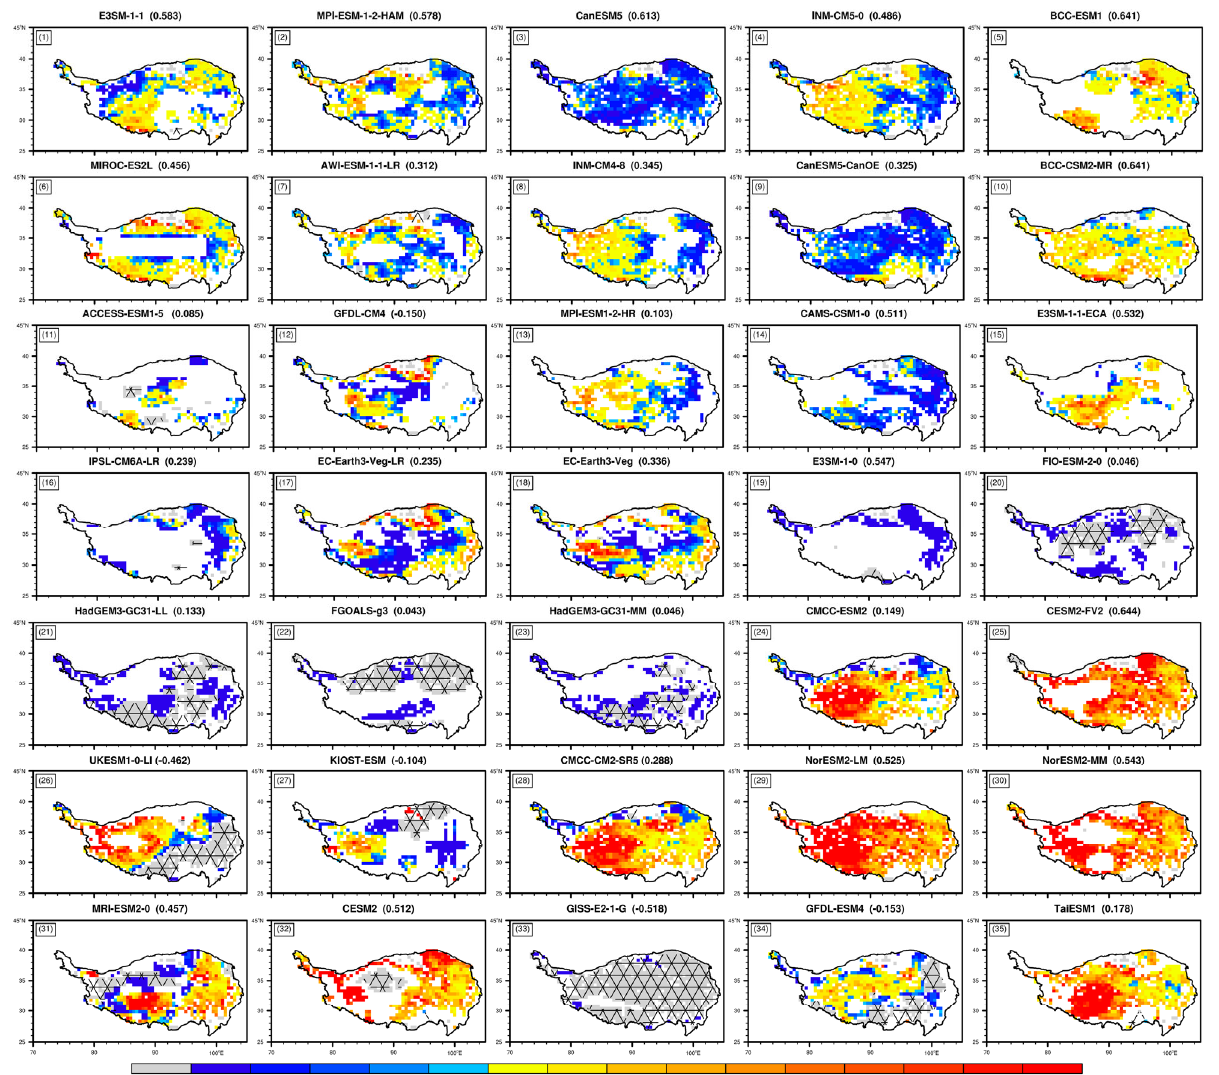
Figure 9. Spatial distributions of the ratio of simulated and observed linear trends in LAI during the growing season. The grid cells with colors all showed a statistically significant interannual change ( p < 0.05). Gray areas mean the grid cells did not capture greening or a declining trend during 1981–2014 in the Tibetan Plateau, blue areas mean the grid cells captured the greening or the declining trend but underestimated them, and red areas indicated overestimations of the greening or the de ‐ clining trend. Cross ‐ hatched areas indicate that the LAI trend was negative. The number in the up ‐ per left corner is the ranking of each CMIP6 model for simulating LAI trends. The value in each title is the pattern correlation.